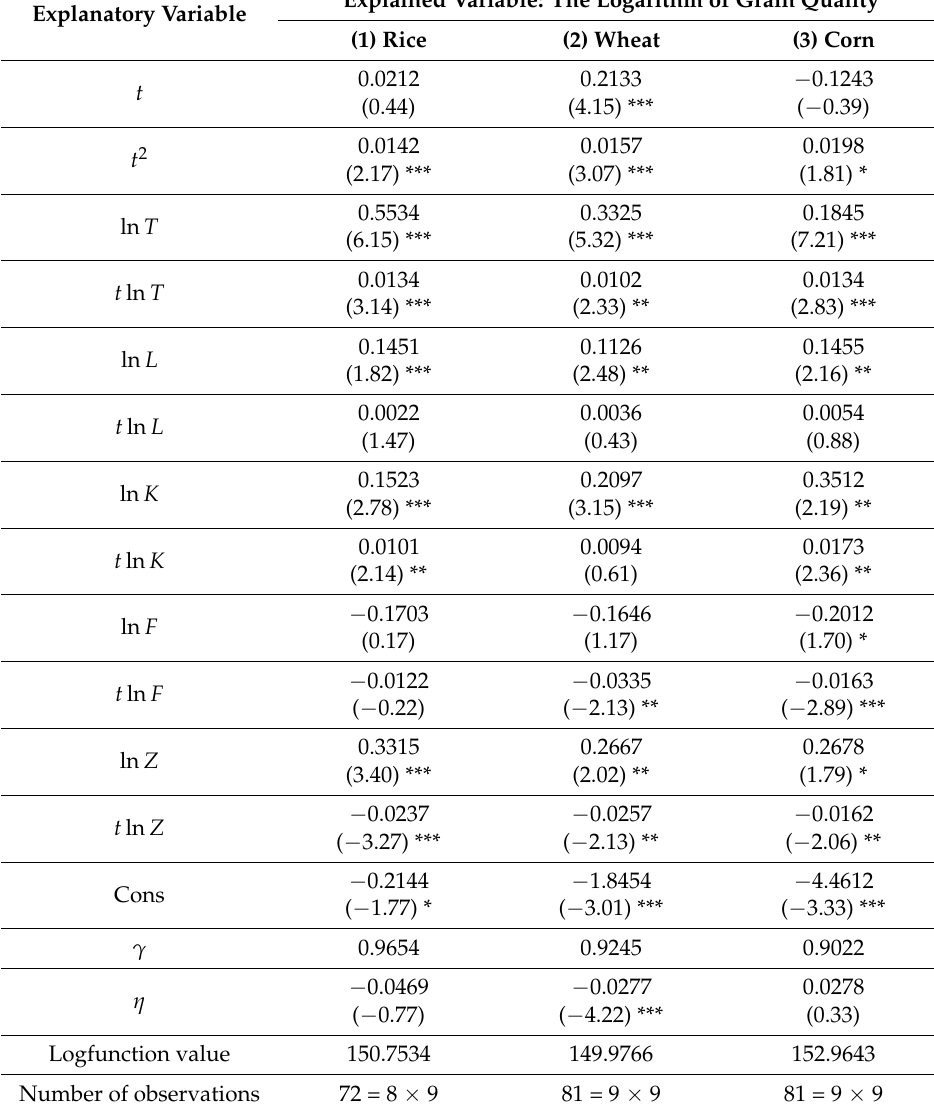
Table 1. Estimate of the determinant of the grain